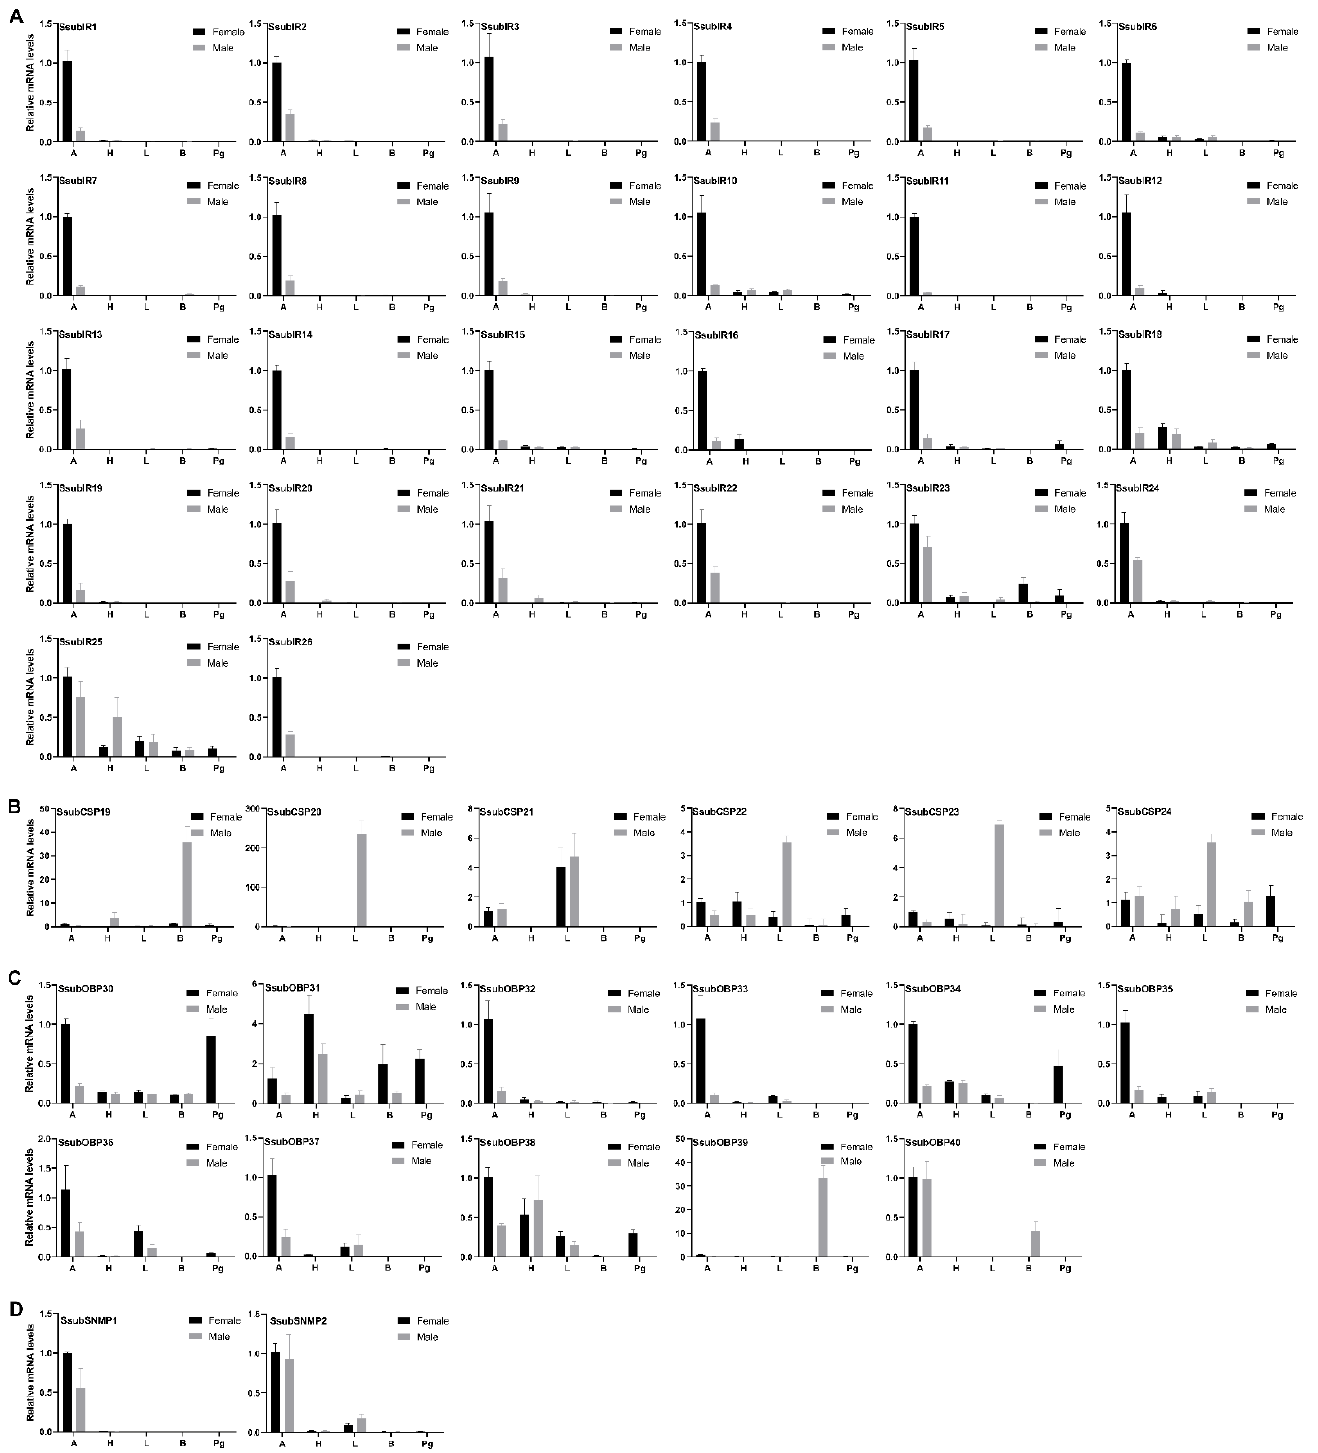
Figure 5. Tissue expression profile of SsubIRs, SsubCSPs, SsubOBPs and SsubSNMPs. ( A ): Expression profiles of SsubIRs. ( B ): Expression profiles of SsubCSPs. ( C ): Expression profiles of SsubOBPs. ( D ): Expression profiles of SsubSNMPs. A, antenna; H, head; B, body without antennae, head, legs, or pheromone gland; L, leg; Pg, pheromone gland. The black columns represent female moths. The grey columns represent male moths. The expression levels are relative to those in female